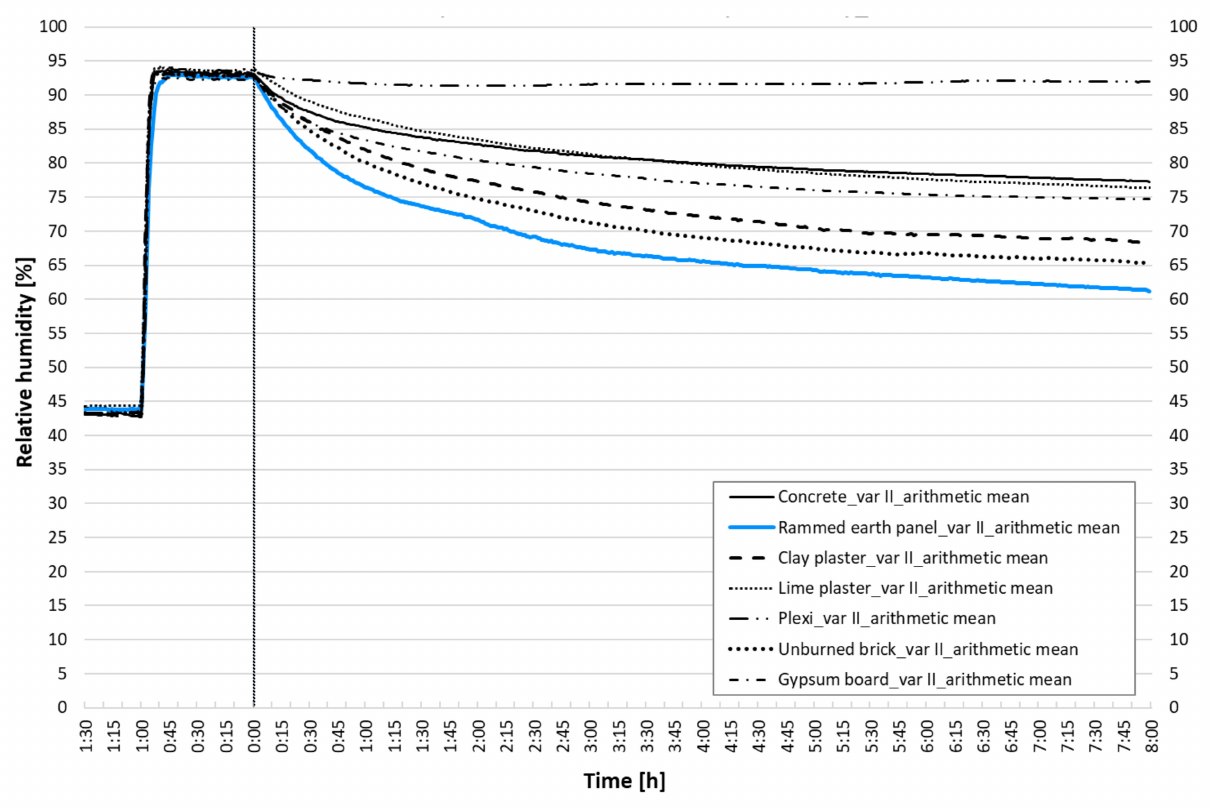
Figure 8. Dynamic adsorption of wall elements: arithmetic